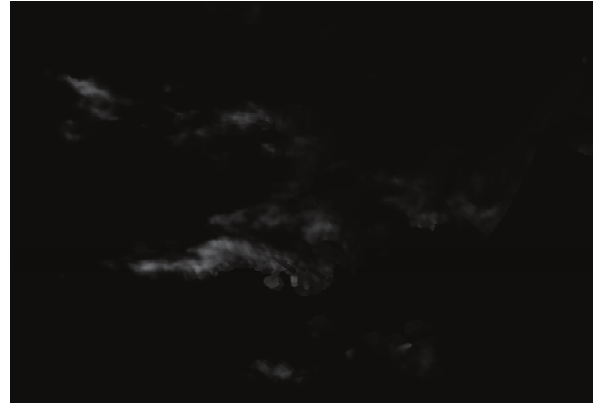
Figure 6. Conversion result of the rainfall data measured by the X-band MP radar (2017.7.5 13:00).